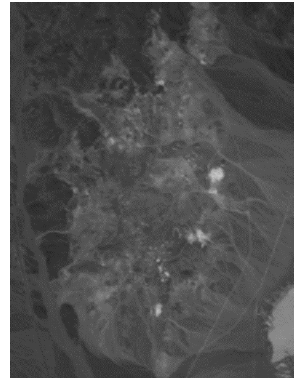
Figure 3. Band 30 of the experimental subimage